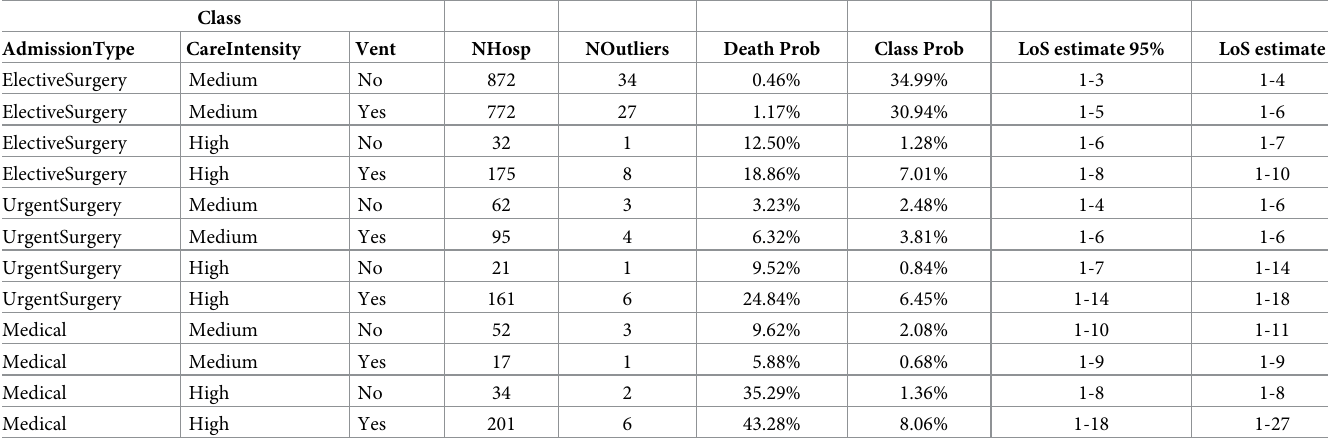
Table 3. Statistics on the 3-feature classification.